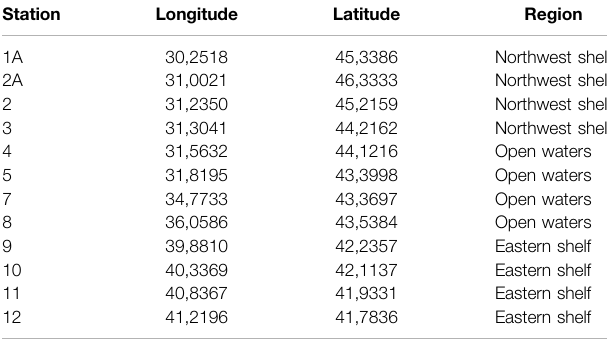
TABLE 1 | Coordinates and regions of the sampling